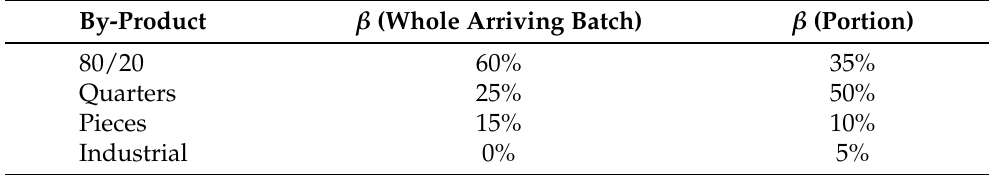
Table A3. By-product